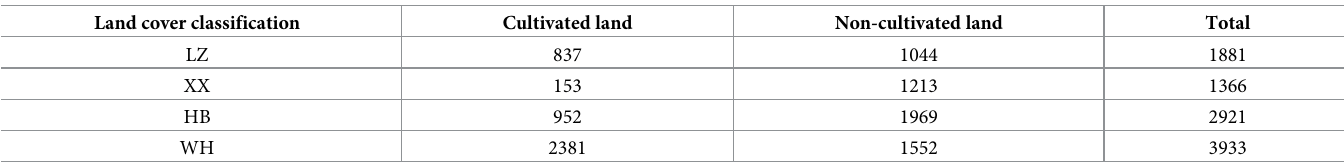
Table 3. Numbers of verification samples in the four sub-study areas (pixels). Land cover